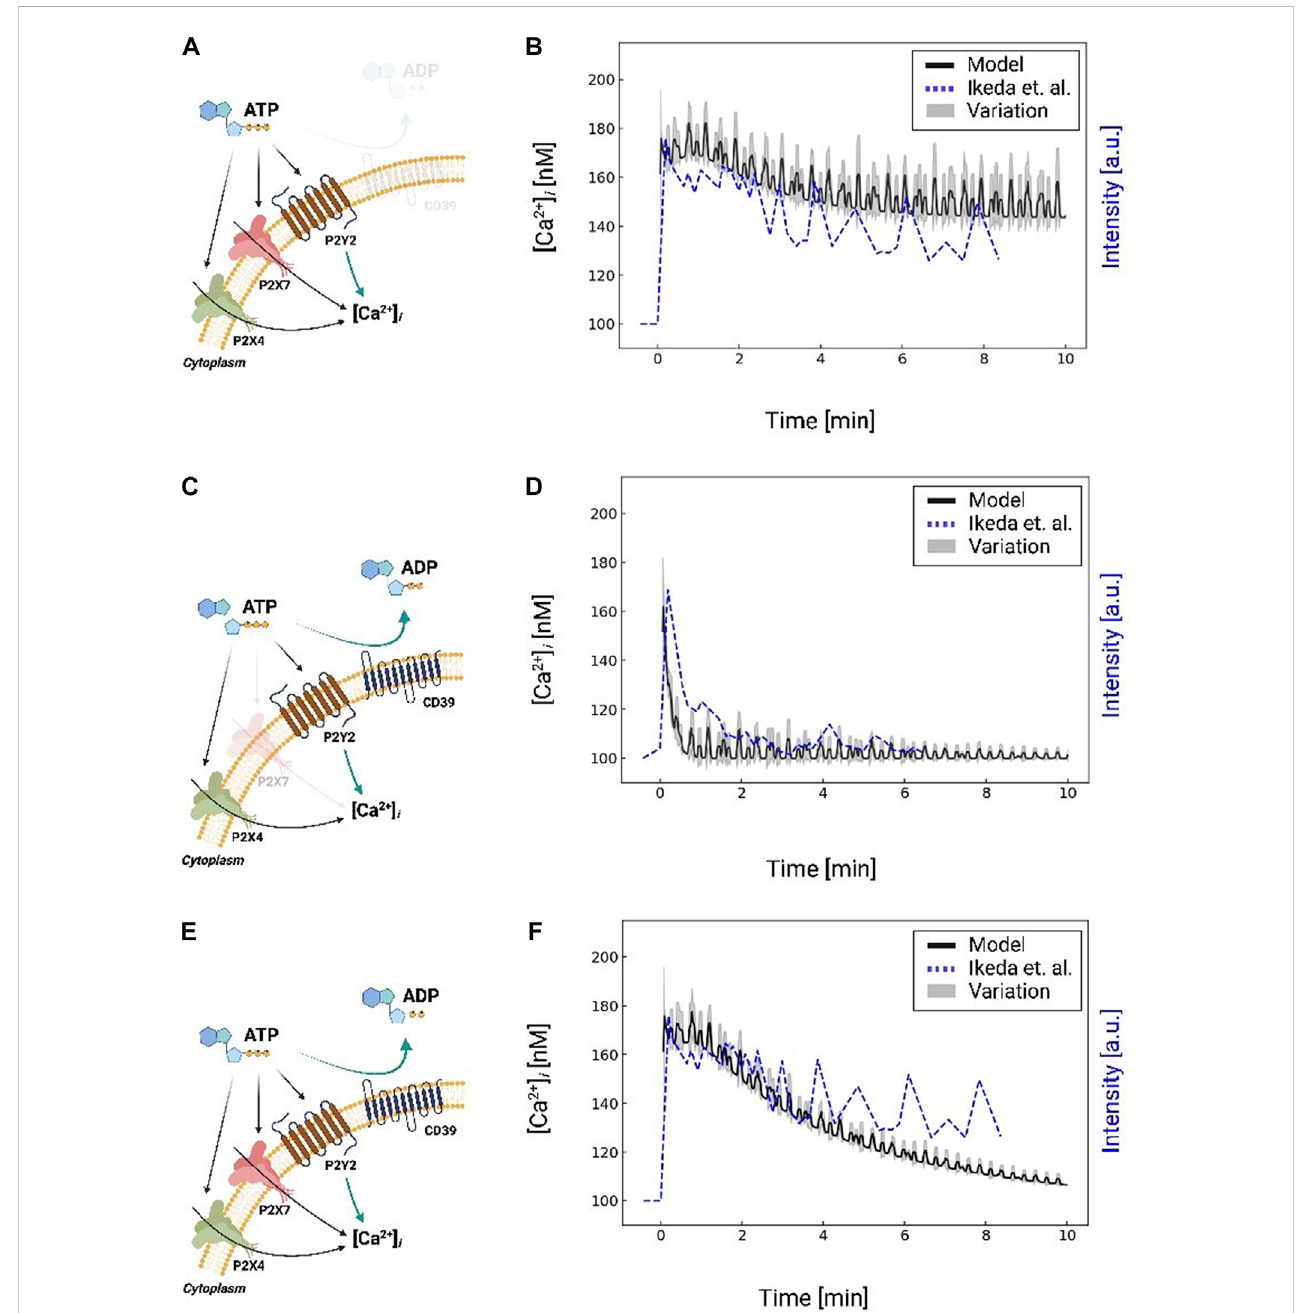
FIGURE 4 Schematic A for Ca 2+ waveforms generated in a control system comprising P2X4, P2X7, and P2Y2 in response to 1 mM ATP for 10 min, but excluding CD39nucleotidaseactivity.Schematic (A) isanalogoustoSchematic (C) ,butincludesCD39nucleotidasedegradationofATPandexcludesP2X7.SchematicC is analogous to Schematic E, but includes P2X7. Schematic (E) for Ca 2+ waveforms generated in a control system comprising P2X4, P 2 X 7, and P 2 Y 2 and includes CD39 nucleotidase activity. Schematic (B, D, and F) comparison of predicted (black: moving average with a window size of 8) and are reported along the left y -axis. The experimentally-measured (Ikeda et al. (2013), dashed blue) Ca 2+ transients are plotted against the right y -axis, corresponding to the schematic (A, C, and E) , respectively. Results excluding P2X7 and CD39 are shown in Supplementary Figure